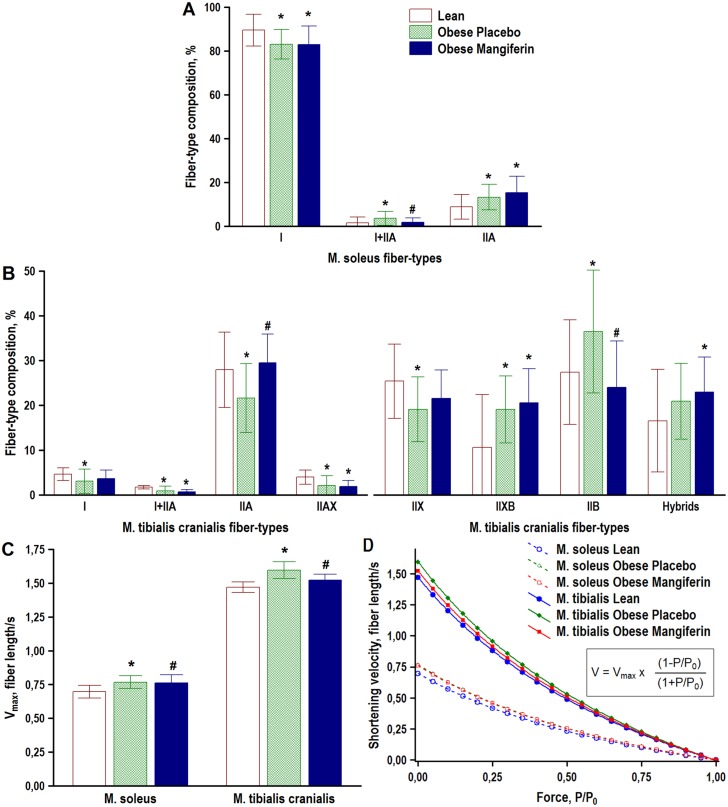
Effect of mangiferin treatment on muscle fiber-type composition, and predicted muscle maximal shortening velocity (Vmax) and the muscle force-velocity relationship in obese rats.The percentages of myosin-based fiber-types (A, B), and predicted Vmax (C) and force-velocity curves (D), dereived according to the Hill-type mathematical model (inset) [42], were determined in Zucker rats with the lean (Fa/Fa or Fa/fa) phenotype (Lean), and Zucker rats with the obese (fa/fa) phenotype that were treated with either placebo (Obese Placebo) or 15 mg/kg BW/day of Mangiferin for 8 weeks (Obese Mangiferin). Bars show means ± SD, n = 20 rats/group. * P < 0.05 vs Lean, # P < 0.05 vs Obese Placebo (one-way ANOVA with Fisher LSD post-hoc test). Data in D are expressed as means of 20 rats/group. V, shortening velocity; Vmax, maximal shortening velocity; P, isometric tension; P0, maximal isometric tension.